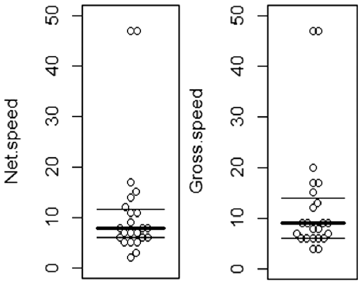
Fig. 9 Beeswarm plots representing students’ typing net and gross speeds. ○ represents each student’s word per minute. Solid lines represent the first and third quartiles. Thick lines represent the